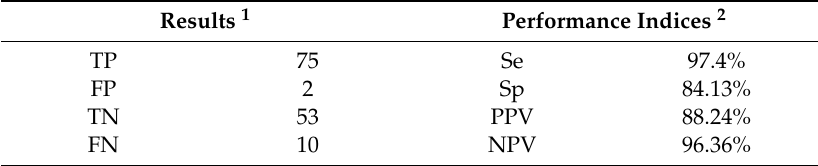
Table 1. Performance indices of the p-60 biosensor with 5 µ g mL − 1 antibody concentration.